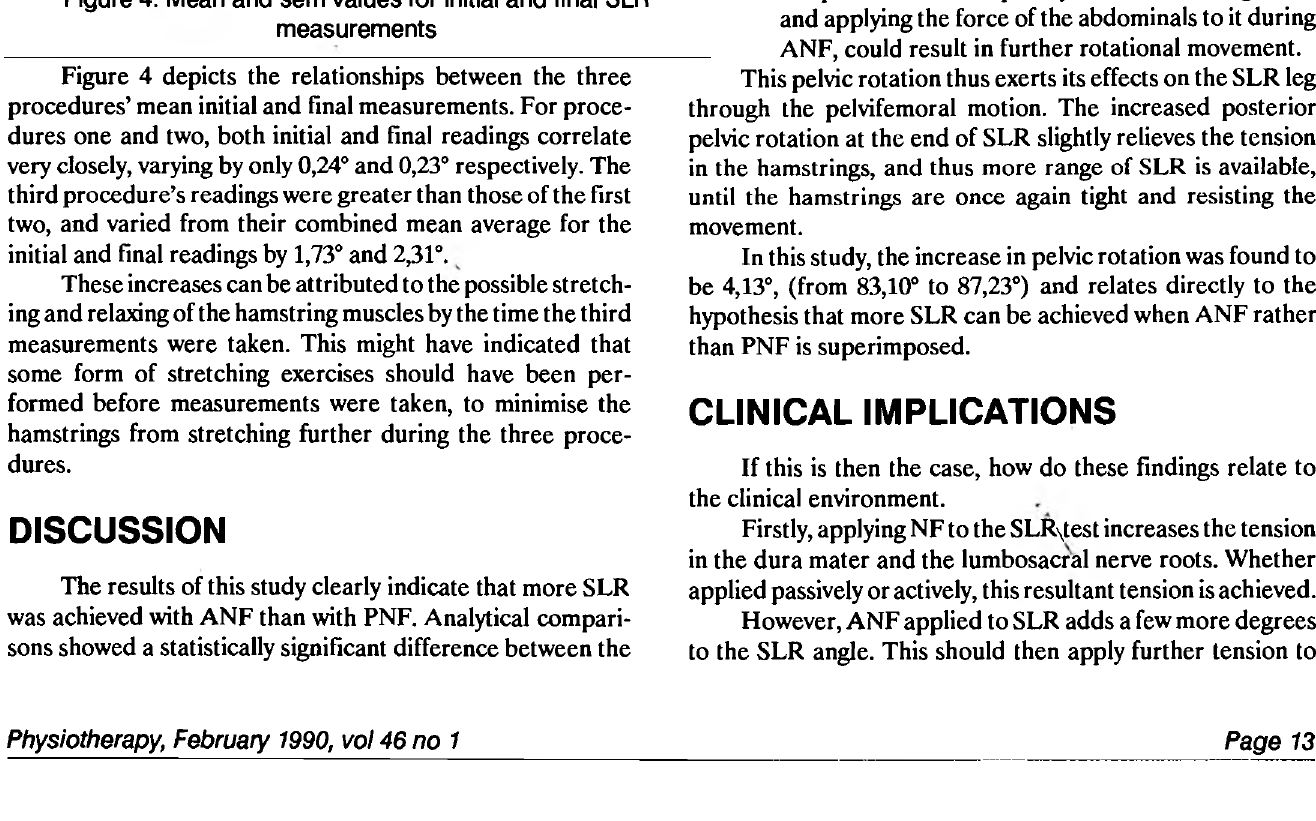
Figure 4: Mean and sem values for initial and final SLR